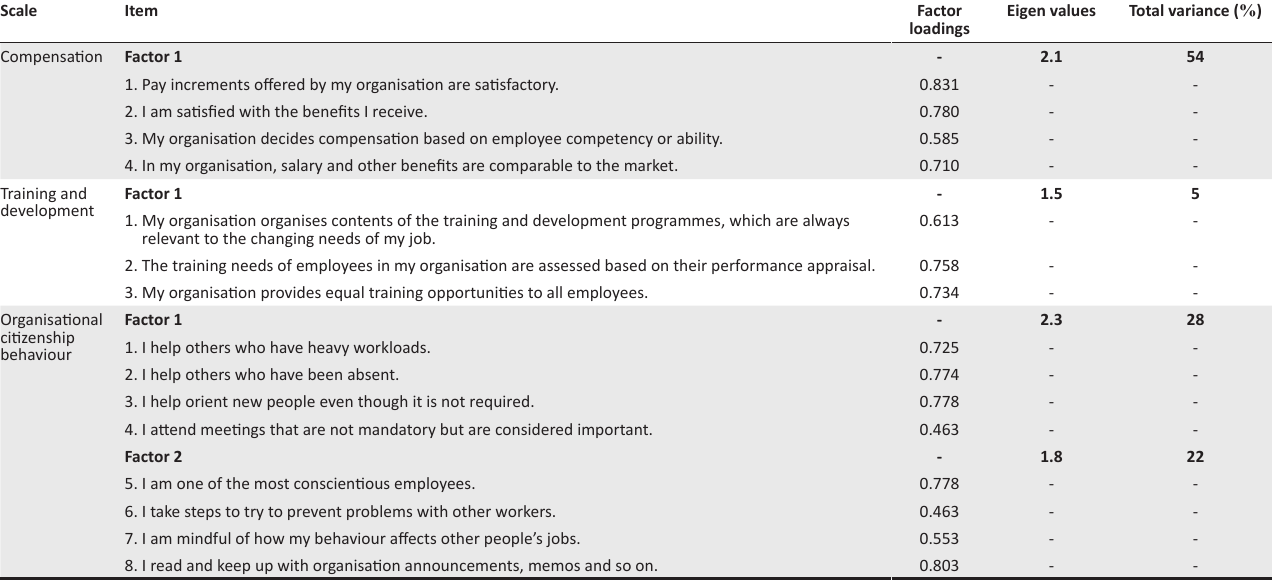
TABLE 3: Compensation, training and development and organisational citizenship behaviour scale. Scale